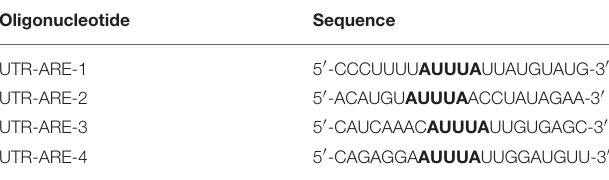
TABLE 3 | Oligonucleotides used in REMSA and REMSA Supershift experiments. Oligonucleotide